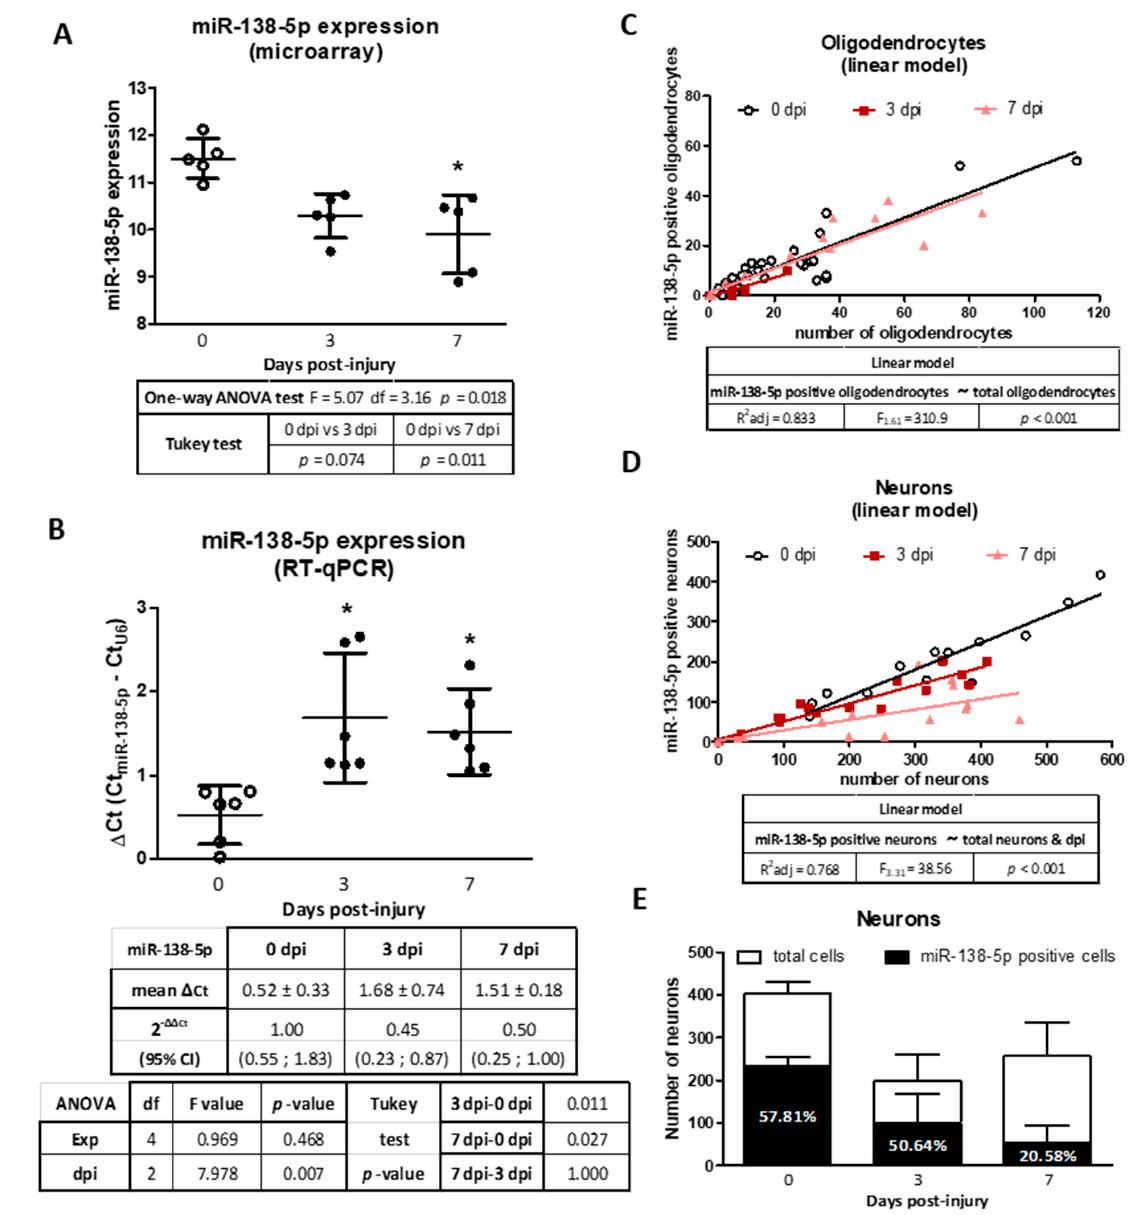
Figure 2. Changes in miR-138-5p expression at 3 and 7 days after SCI: ( A ) Spinal cord expression of miR-138-5p according to microarray data from Yunta and cols. (2012). The dot plot represents the average expression ± SD from five animals. ( B ) RT-qPCR showing the relative miR-138-5p expression in spinal cord samples collected at the indicated days post-injury. The graph represents the average of Δ Ct from six independent experiments ± 95% CI. ( C – E ) Analysis of miR-138-5p expression in oligodendrocytes and neurons from FISH-stained slices of spinal cord sampled at 0, 3, and 7 dpi. The linear model adjusted in ( C ) relates the number of miR-138-5p positive oligodendrocytes in each section (dependent variable) with the total number of oligodendrocytes in the section (independent variable). Including the time after injury (dpi) in the model did not improve its adjustment and was discarded. ( D ) An equivalent linear model adjusted for the number of miR-138-5p positive neurons (dependent variable) indicates that it depends on the total number of neurons present and the day after injury (dpi). ( E ) Bar graph detailing the average number of neurons and miR-138-5p positive neurons per section in spinal cords from 3 animals per time after injury ± SD. * denotes p < 0.05.